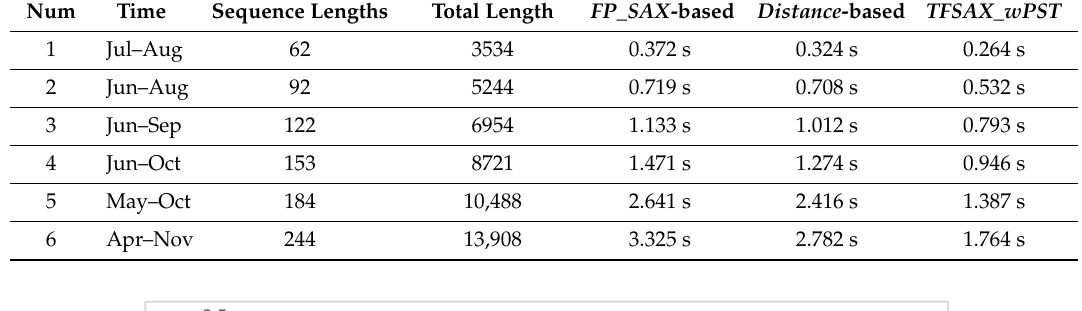
Table 12. The execution time of different approaches.